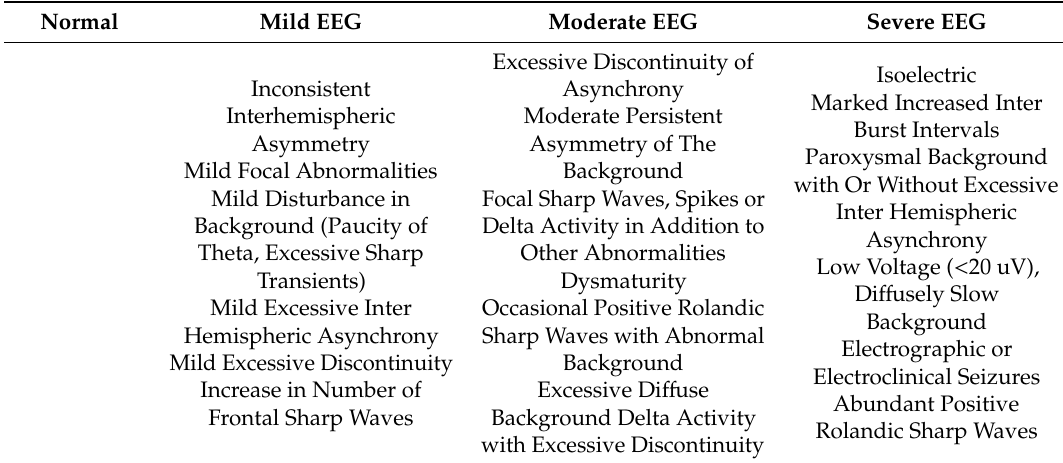
Table 1. Neonatal Electroencephalogram (EEG) severity scoring (adapted from Tharp and Laboyrie, permissions obtained).